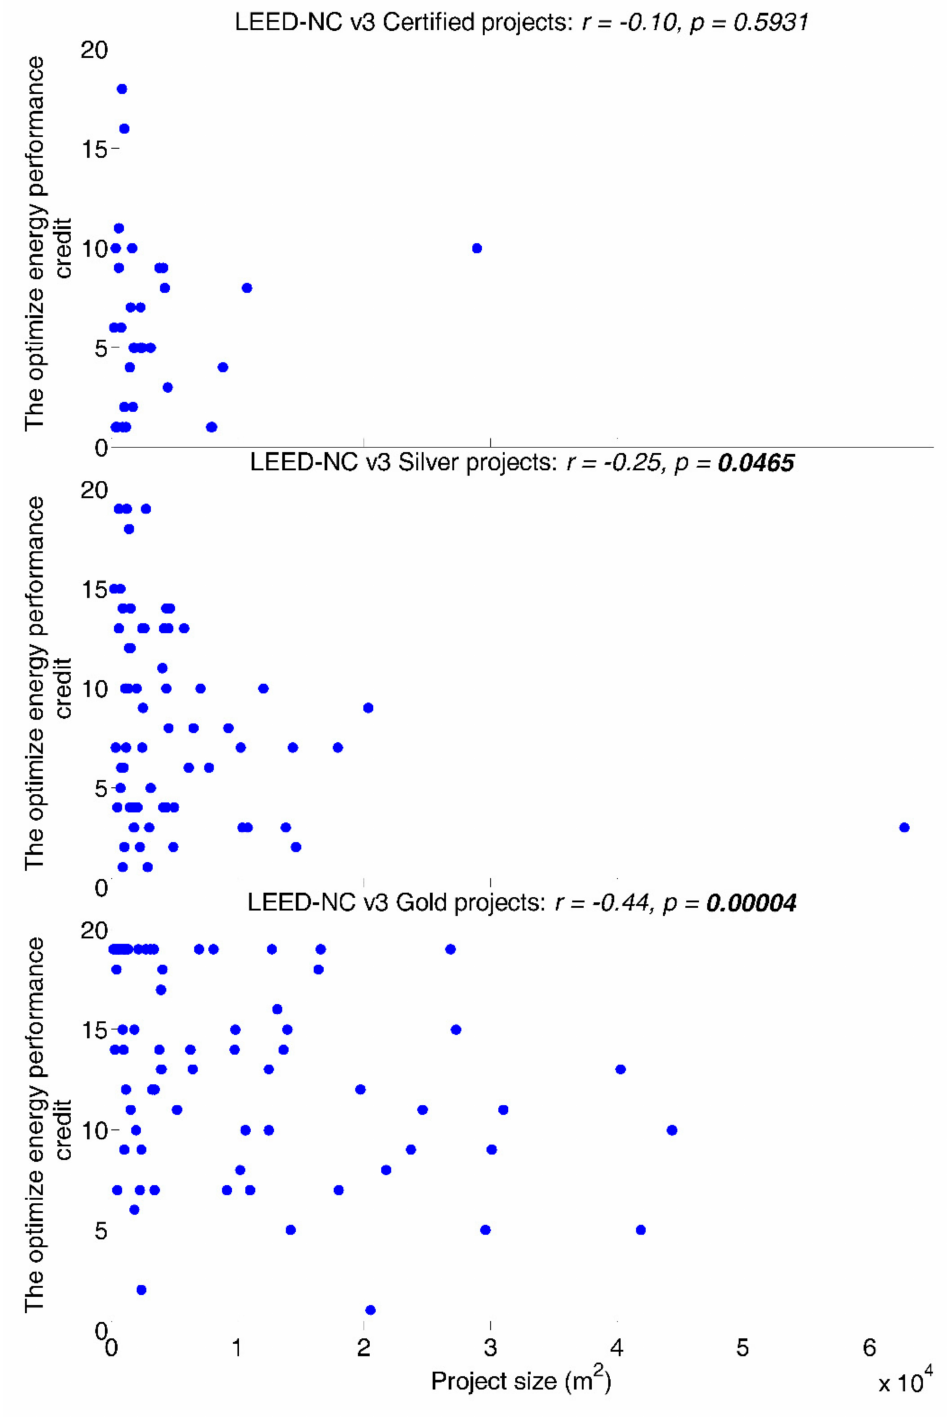
Figure 1. LEED-NC v3 office-type projects: optimized energy performance credit versus project